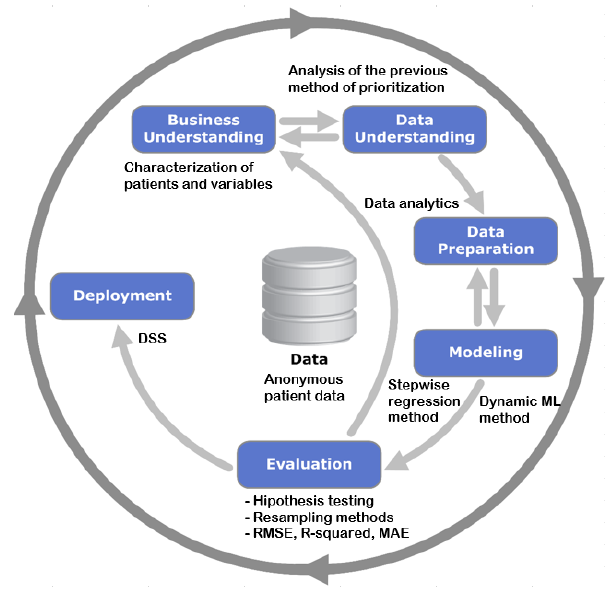
Figure 1. CRISP-DM method of this research.